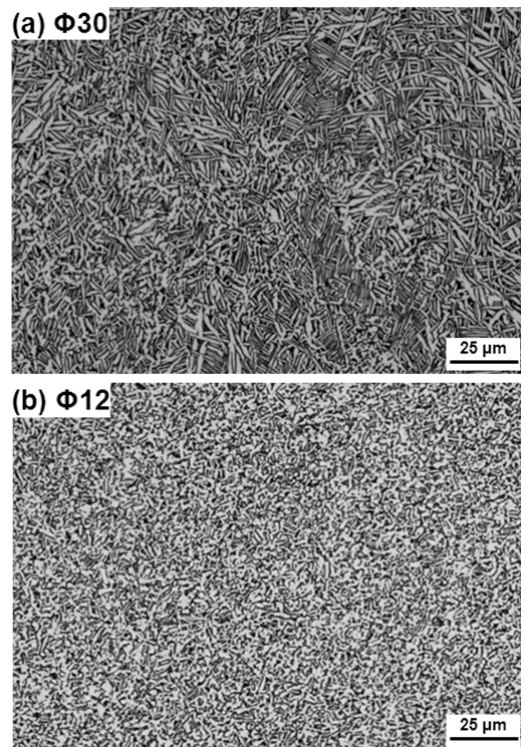
Figure 20. Microscopy images of hot-rolled Ti-15Zr-4Nb-4Ta alloy B. Hot-rolled to diameters of ( a ) 30; and ( b ) 12